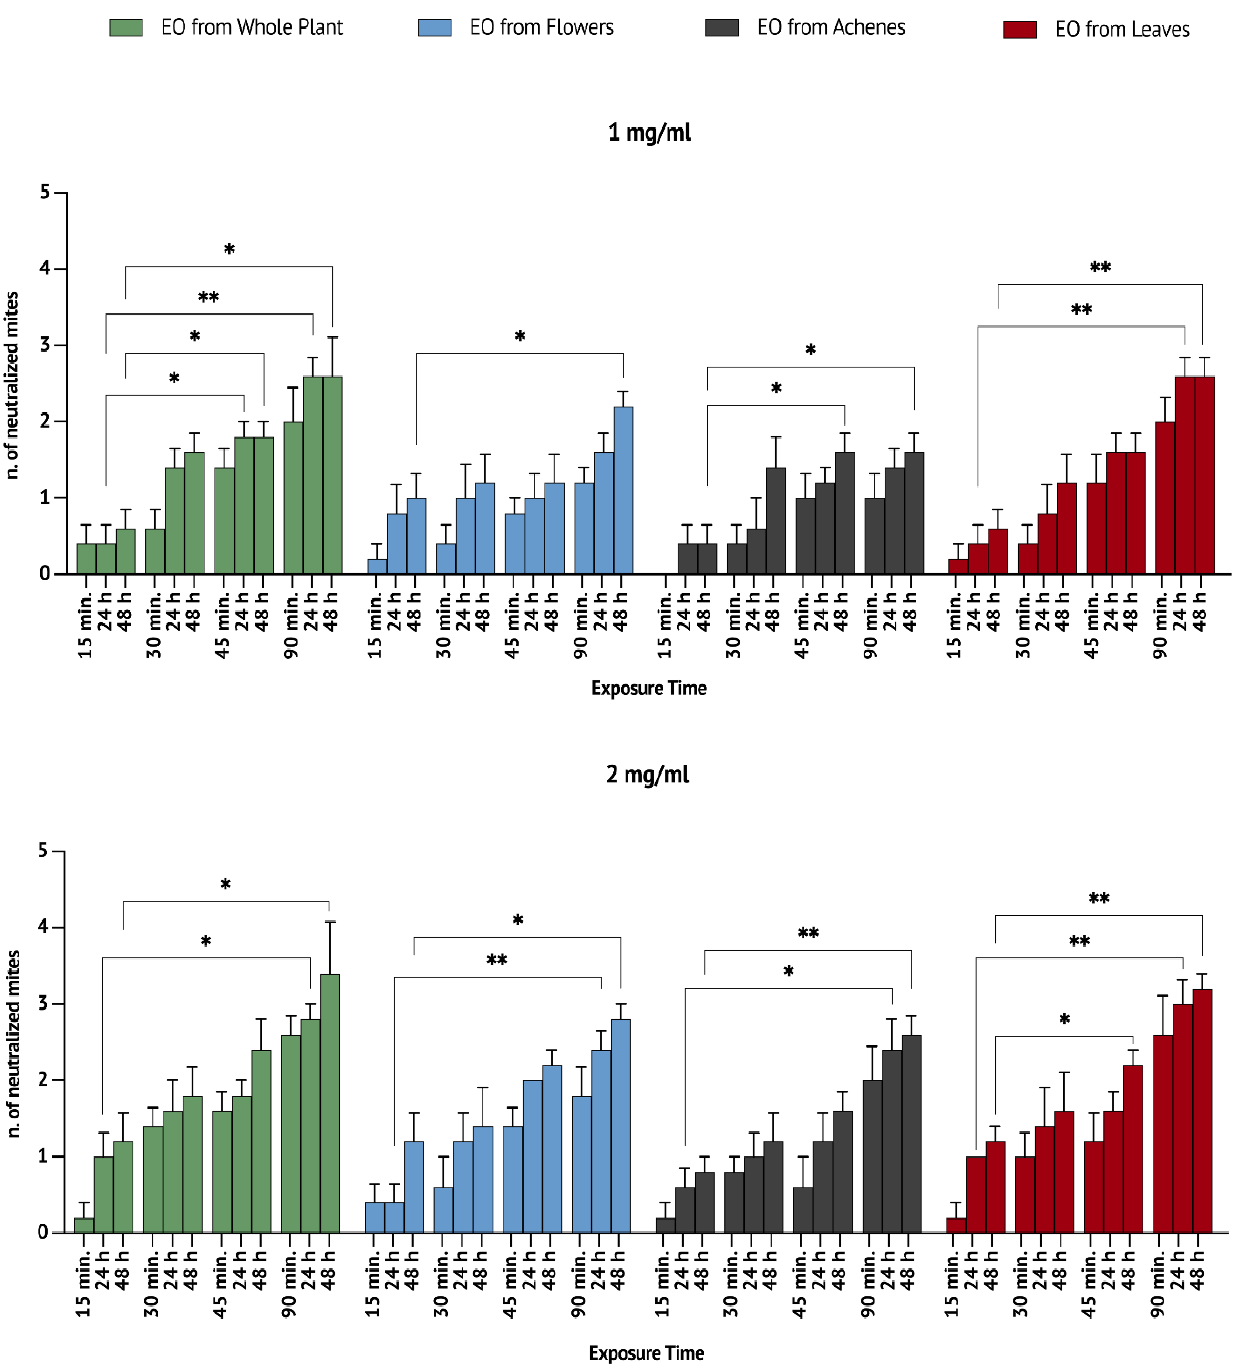
Figure 2. Number of neutralized mites after the incubation of the surviving mites with a honeybee larva (as nourishment) after 24 and 48 h of exposure to EO vapours at the concentrations of ( above ) 1 mg/mL and ( below ) 2 mg/mL. The results are expressed as means ± SEMs. * p < 0.05, ** p < 0.01.